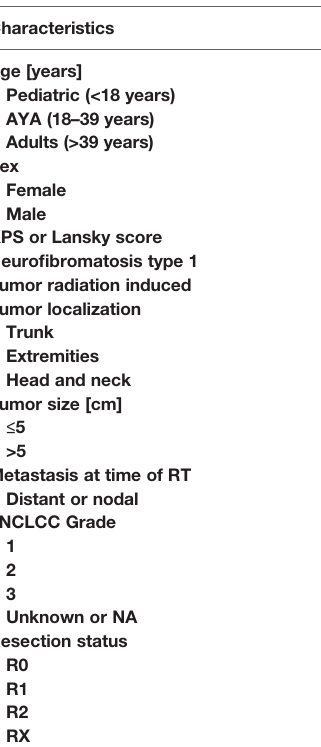
TABLE 1 | Patient